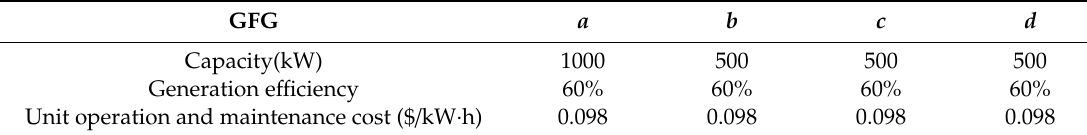
Table 3. Equipment parameters of the gas-fired generators (GFGs)